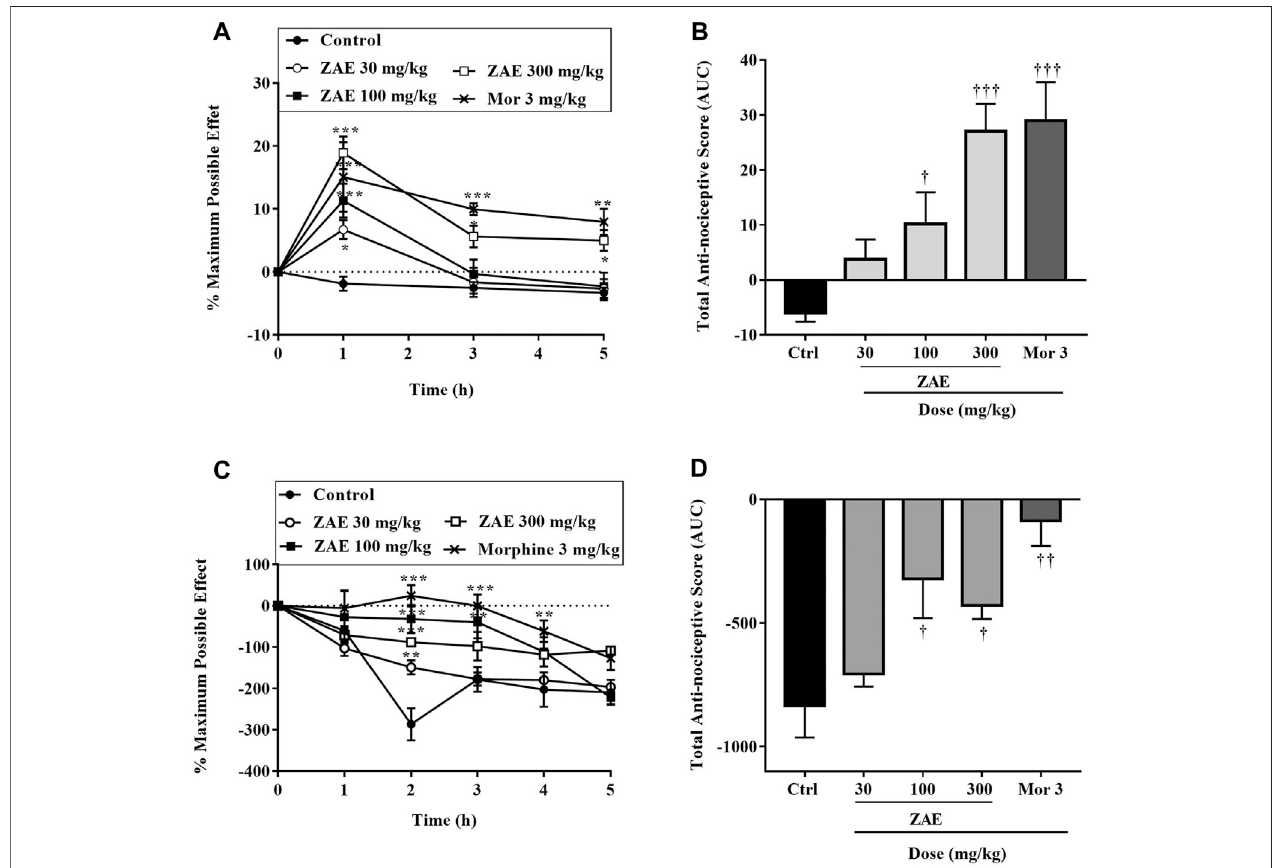
FIGURE 6 | Effect of pre-treatment of rats with ZAE and morphine on bradykinin (A, B) and prostaglandin E 2 (C and D) - induced hyperalgesia. Data (C and D) represent the time-course curves whereas (B – D) represent total anti-nociceptive effects (AUC). The symbols * p < 0.05; ** p < 0.01; *** p < 0.001 denote signi fi cant differencesintime-coursecurvesoftreatmentcomparedtothecontrol(Ctrl)group(two-wayANOVAfollowedbyDunnet ’ smultiplecomparisontest)whereas † p < 0.05, †† p < 0.01, ††† p < 0.001 denote signi fi cantdifferencesoftreatmentin comparison withcontrol(Ctrl) group using the one-way ANOVA followed byTukey ’ smultiple comparison